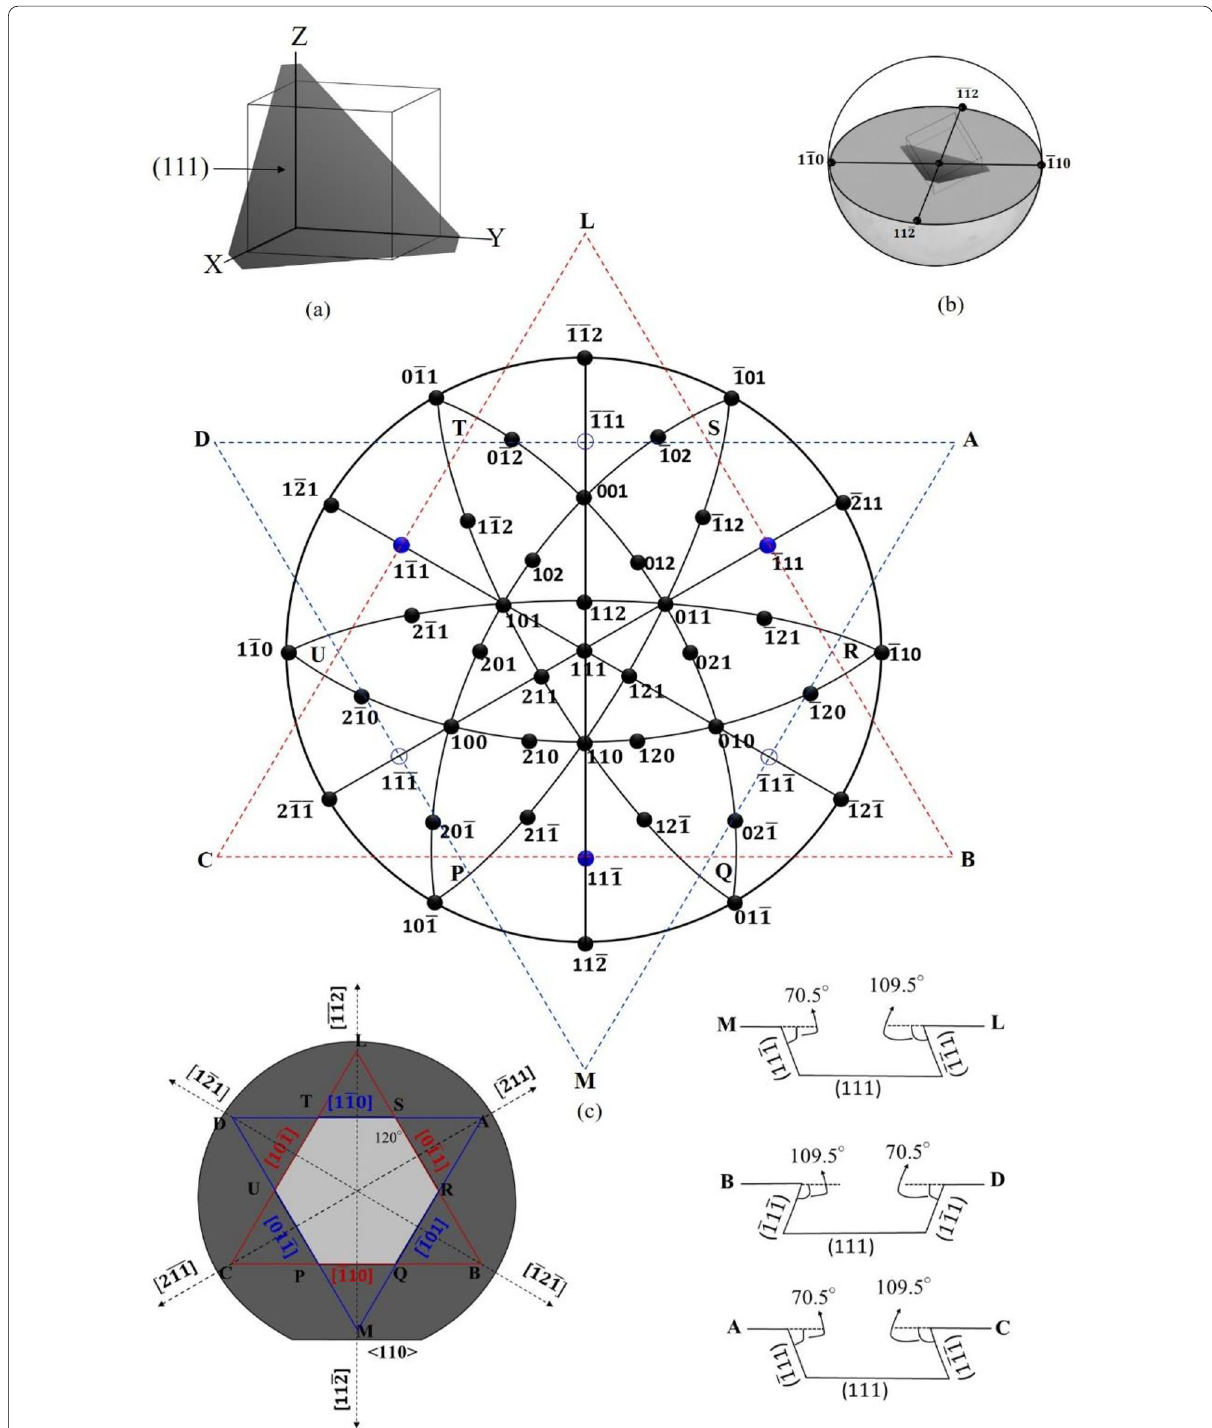
Fig. 1 Schematic representation of stereographic projection of {111} silicon: a (111) plane inside a unit cell, b unit cell at the center of a sphere which is used to project different crystallographic planes on 2D surface, and c stereographic projection exhibiting different planes. The {111} planes projected from the top and bottom hemispheres are shown by solid and open blue circles, respectively. Three {111} planes shown by blue color dots make an angle of 109.5º to the silicon wafer surface plane and 60º with each other, while another three {111} planes indicated by open blue circle form an angle of 70.5º to the surface plane and 60º to each